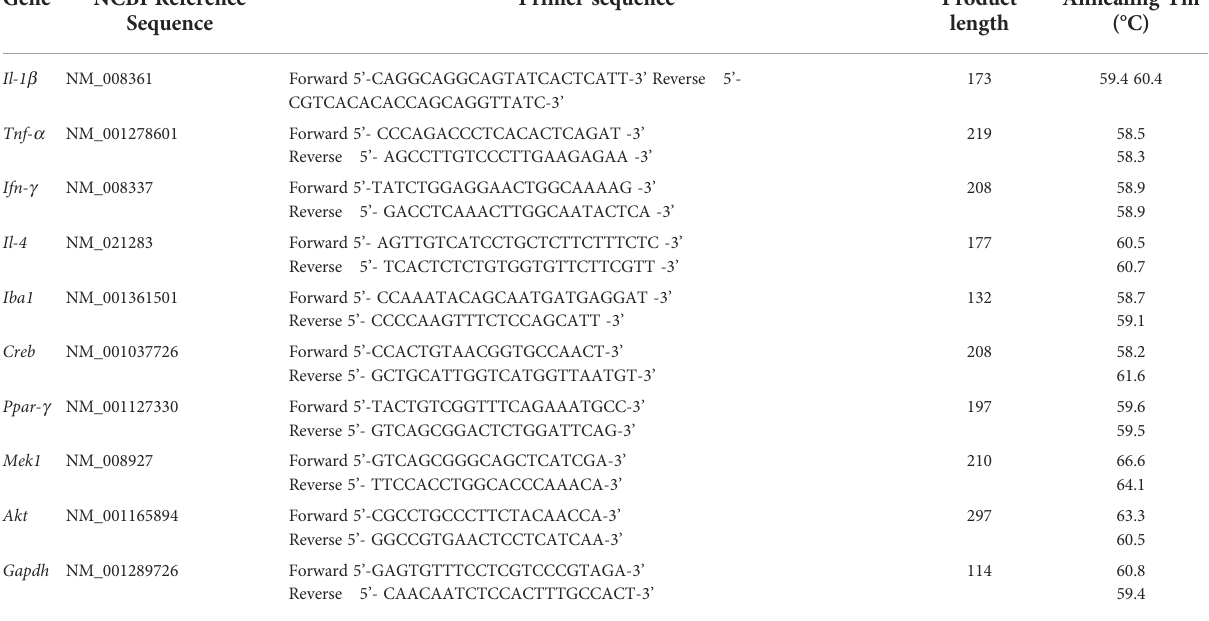
TABLE 2 Fluorescence quantitative PCR